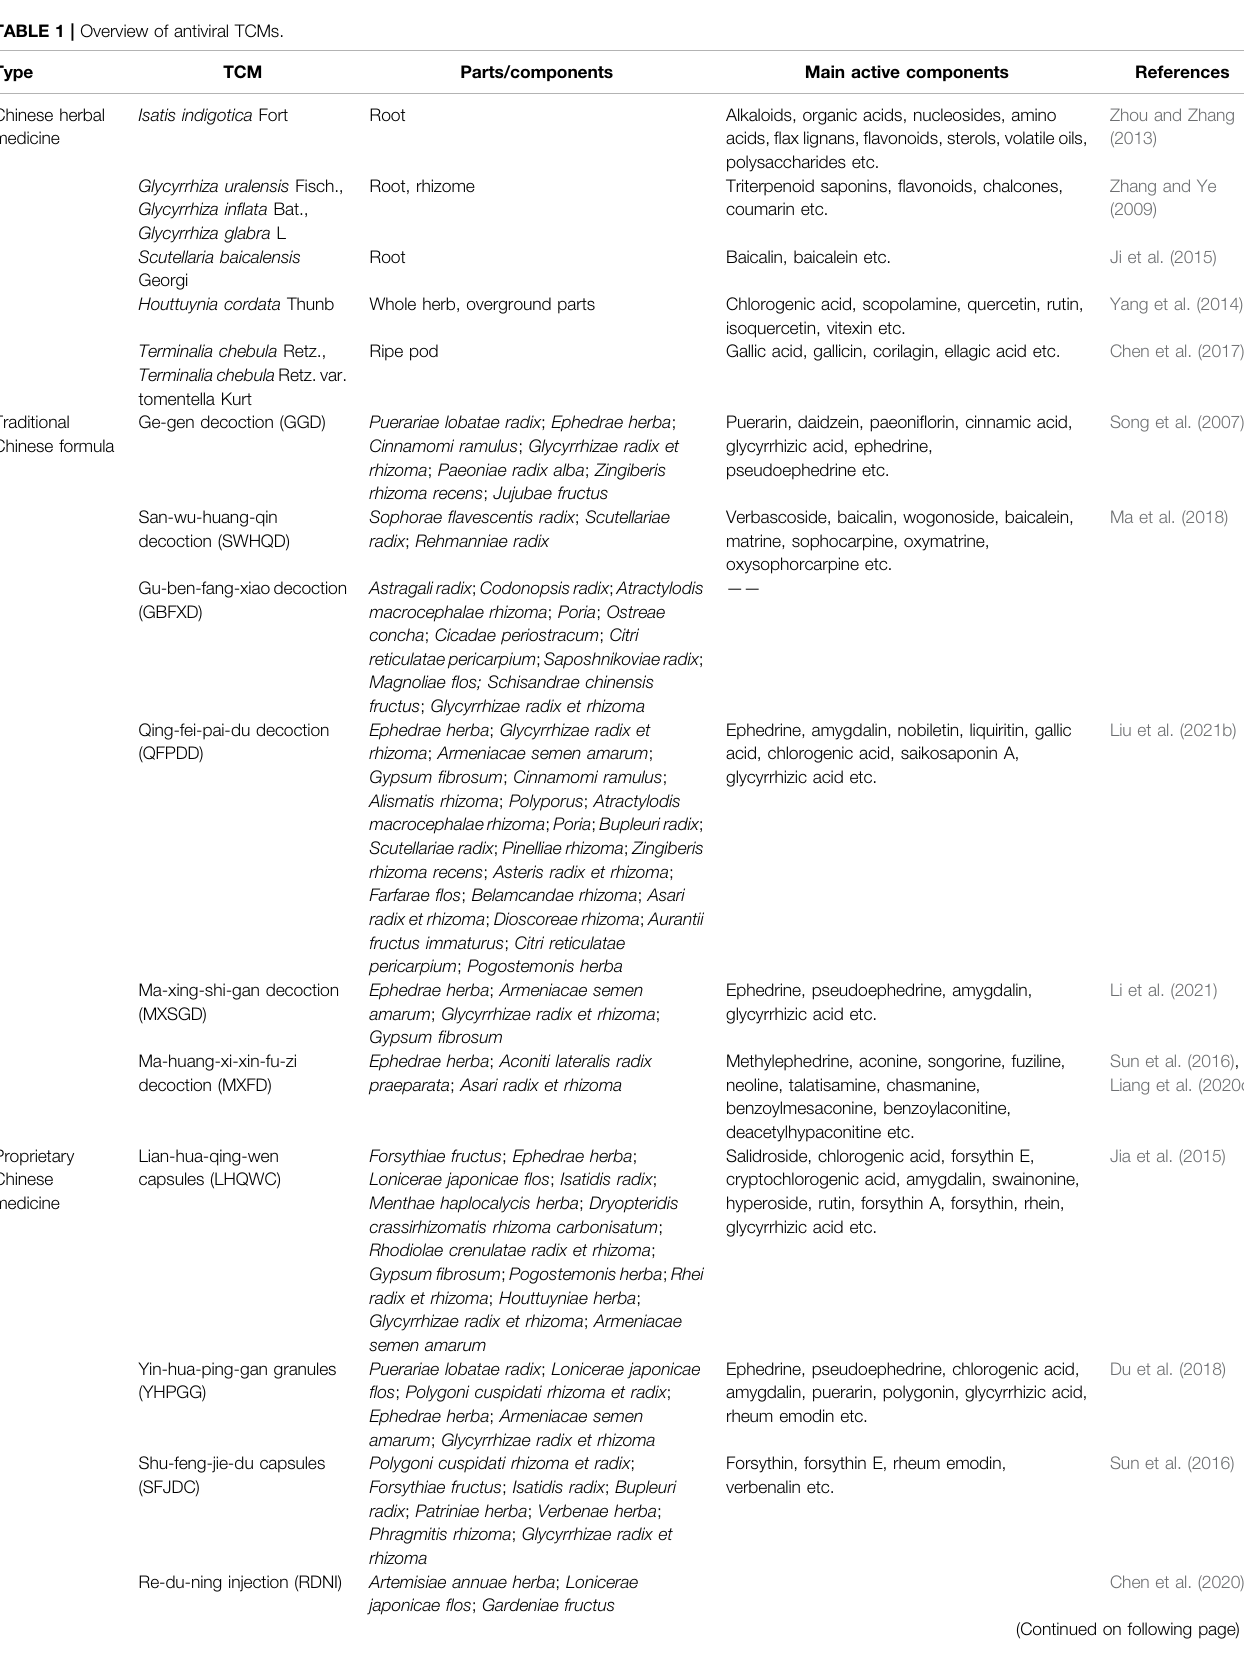
TABLE 1 | Overview of antiviral